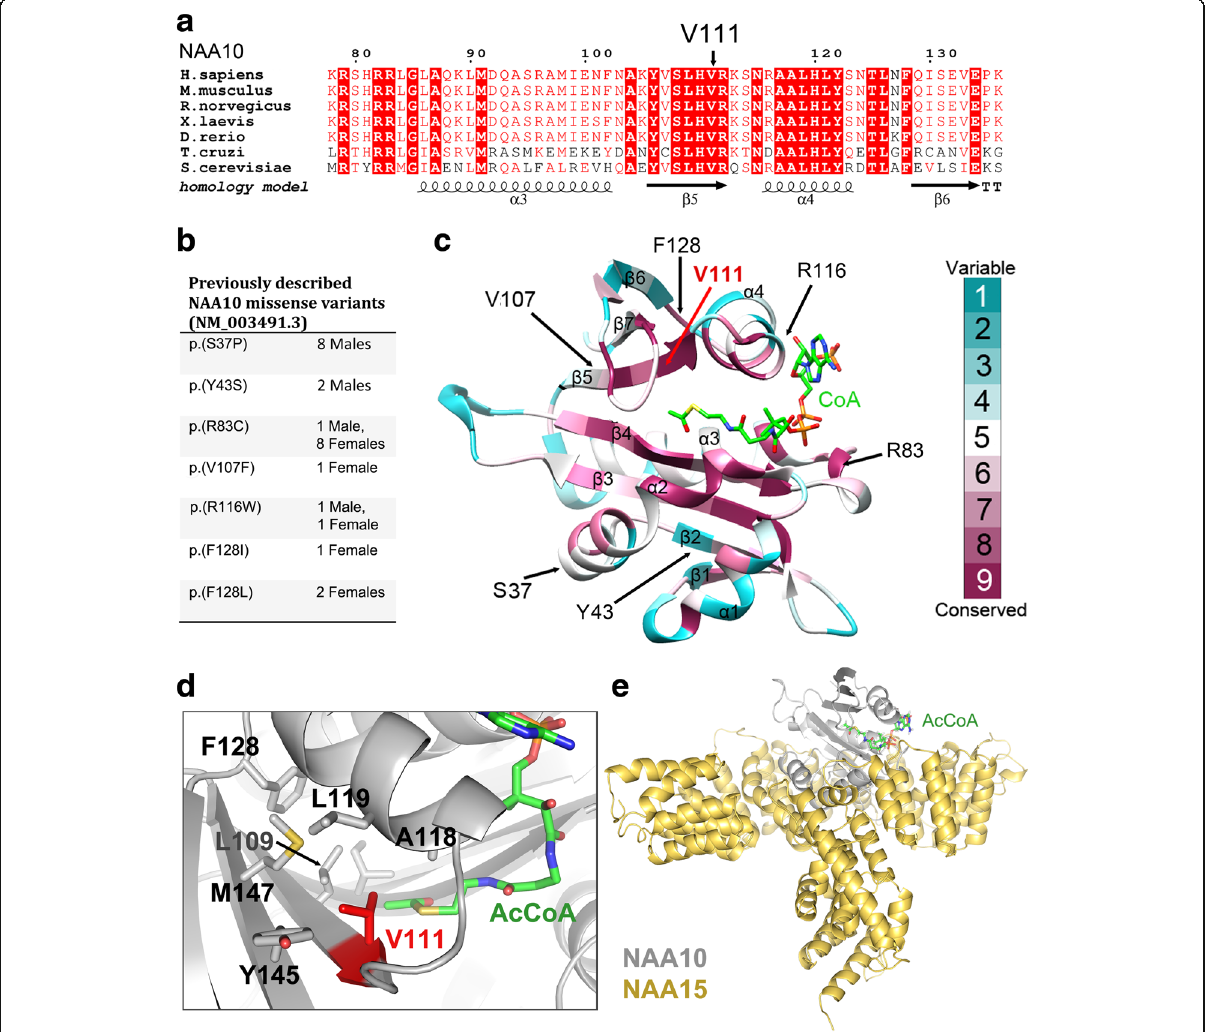
Fig. 1 NAA10 multiple sequence alignment and structural conservation. a NAA10 multiple sequence alignment showing amino acids 78 – 137 (of human NAA10) ( b ) Previously described NAA10 variants identified in patients with ID/DD. c Cartoon representation of NAA10 colored with respect to evolutionary conservation. More conserved regions are colored in dark magenta, less conserved regions are colored in dark cyan. V111 is located towards the end of β 5 and is highly conserved throughout evolution. d The side chain of V111 is pointing towards a hydrophobic pocket together with Y145, M147, L109 and L119. V111 is also located in close proximity to the sulfur-acetyl group of AcCoA, and to the β 6- β 7 loop region that is